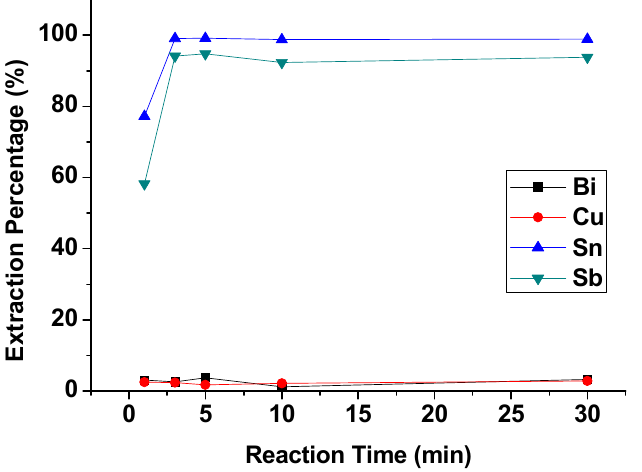
Figure 5. Extraction percentage of metals at different reaction times. (HCl) = 4 M, (TBP) = 1 M, O/A ratio = 1.